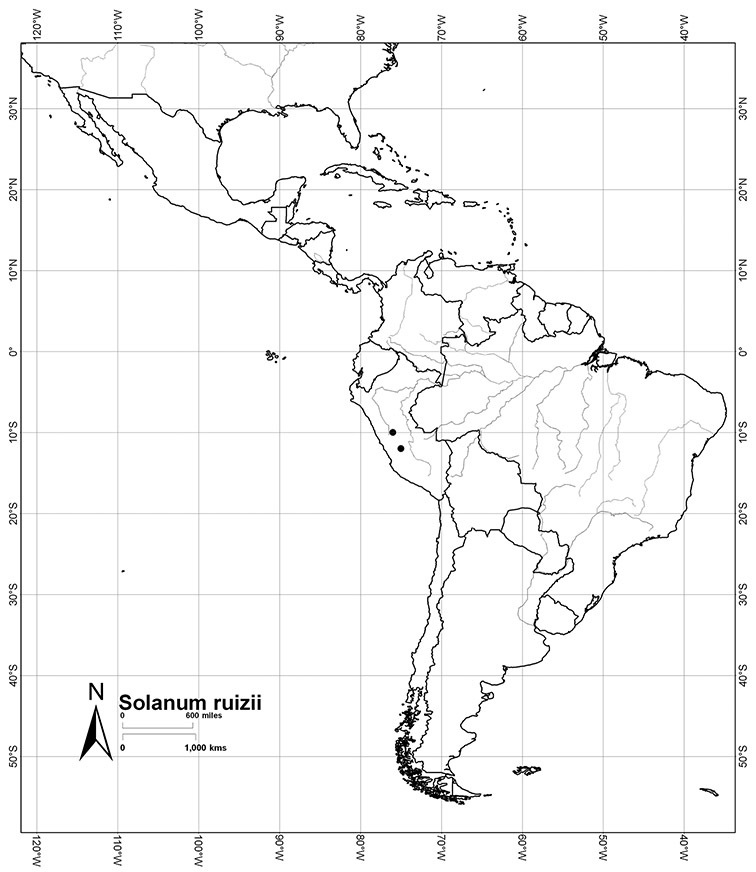
Distribution of Solanum ruizii S.Knapp.